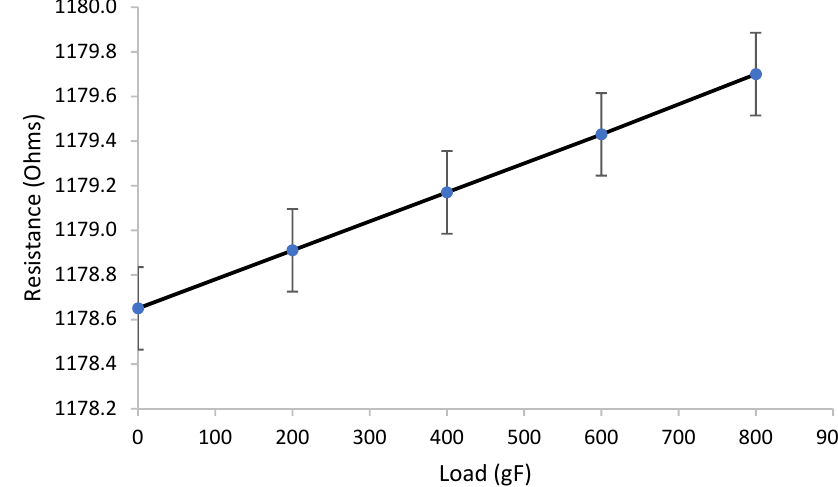
Figure 4. Prototype device response under strain test, sample 102.